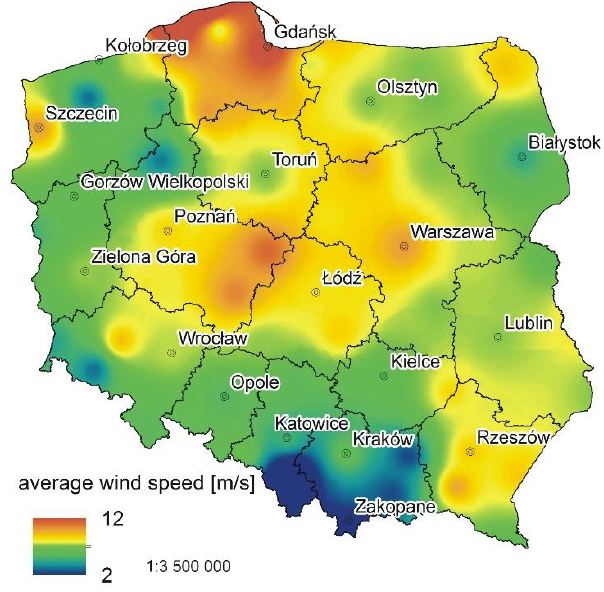
Figure 3. Average wind speed at a height of 100 m (own calculations).